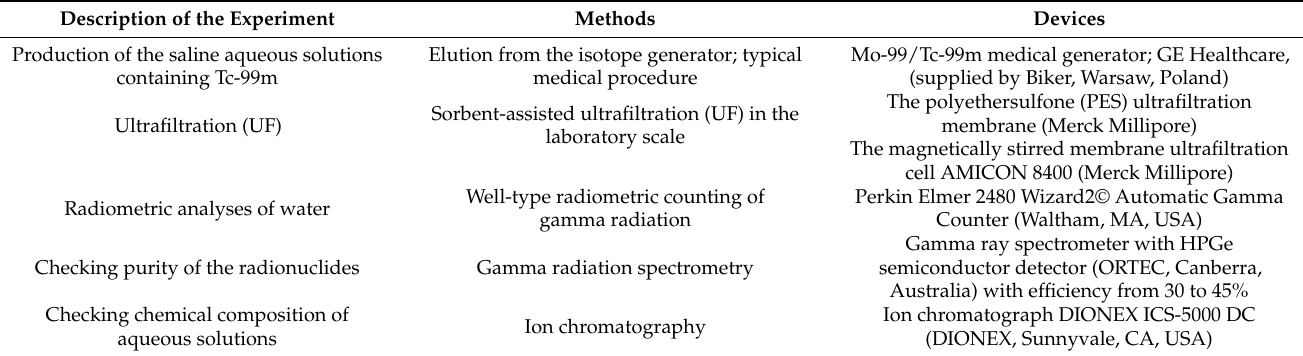
Table 1. Methods for examining the sorbent-assisted UF and the devices used in the present